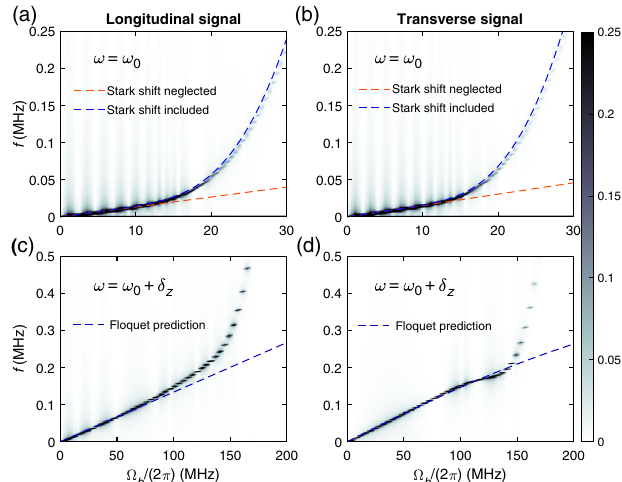
FIG. 3. Bias amplitude sweep. (a) Bias amplitude sweep for longitudinal signal sensing. The intensity plot is the Fourier spectrum of the Rabi signal P ð t Þ under different bias jþi amplitudes Ω b . The transverse bias field is circularly polarized (same for other panels). The signal and bias frequencies are fixed at ω s ¼ ð 2 π Þ 375 MHz and ω b ¼ ω s þ ω 0 − Ω . The signal and spin-locking drive amplitudes are Ω sz ¼ ð 2 π Þ 1 MHz and Ω ¼ ð 2 π Þ 3 MHz, and the spin-locking drive frequency is on resonance with the qubit frequency ω ¼ ω 0 ¼ ð 2 π Þ 50 MHz. Dashed lines are theoretical predictions. (b) Bias amplitude sweep for transverse signal sensing. The parameters are similar to panel (a) except for the resonance condition ω b ¼ ω s þ Ω and signal amplitude Ω sx ¼ ð 2 π Þ 1 MHz. (c,d) Resonance cor- rection with ac Stark shifts. The parameters are the same as in panels (a) and (b) except for the frequency of the spin-locking drive ω ¼ ω 0 þ δ z and the resonance condition ω b ¼ ω s þ ω − Ω for the longitudinal signal, which cancels the ac Stark shift in the rotating